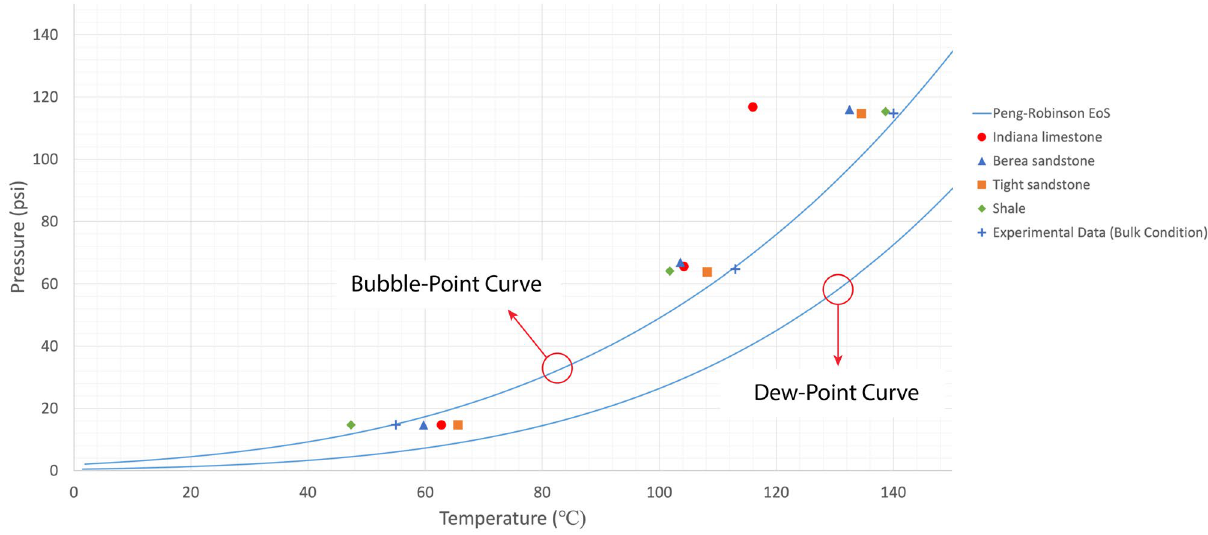
Figure 6. Mean vaporization temperatures of pentane-heptane mixture in various rocks and computed bubble- point/dew-point temperatures obtained from the PR-EoS at different pressures. The experimental data were obtained from the phase-change measurement at bulk conditions.